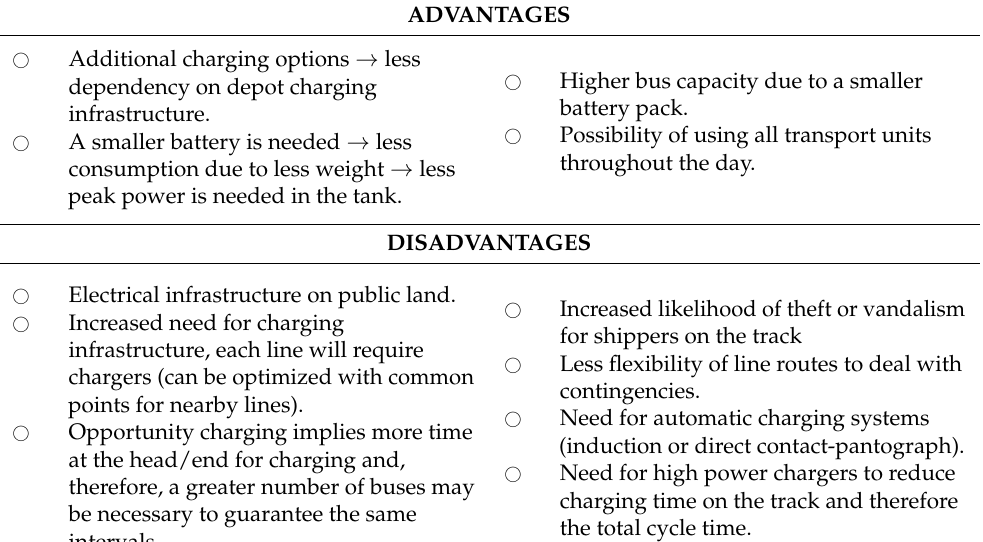
Table 2. Advantages and disadvantages of opportunity charging.